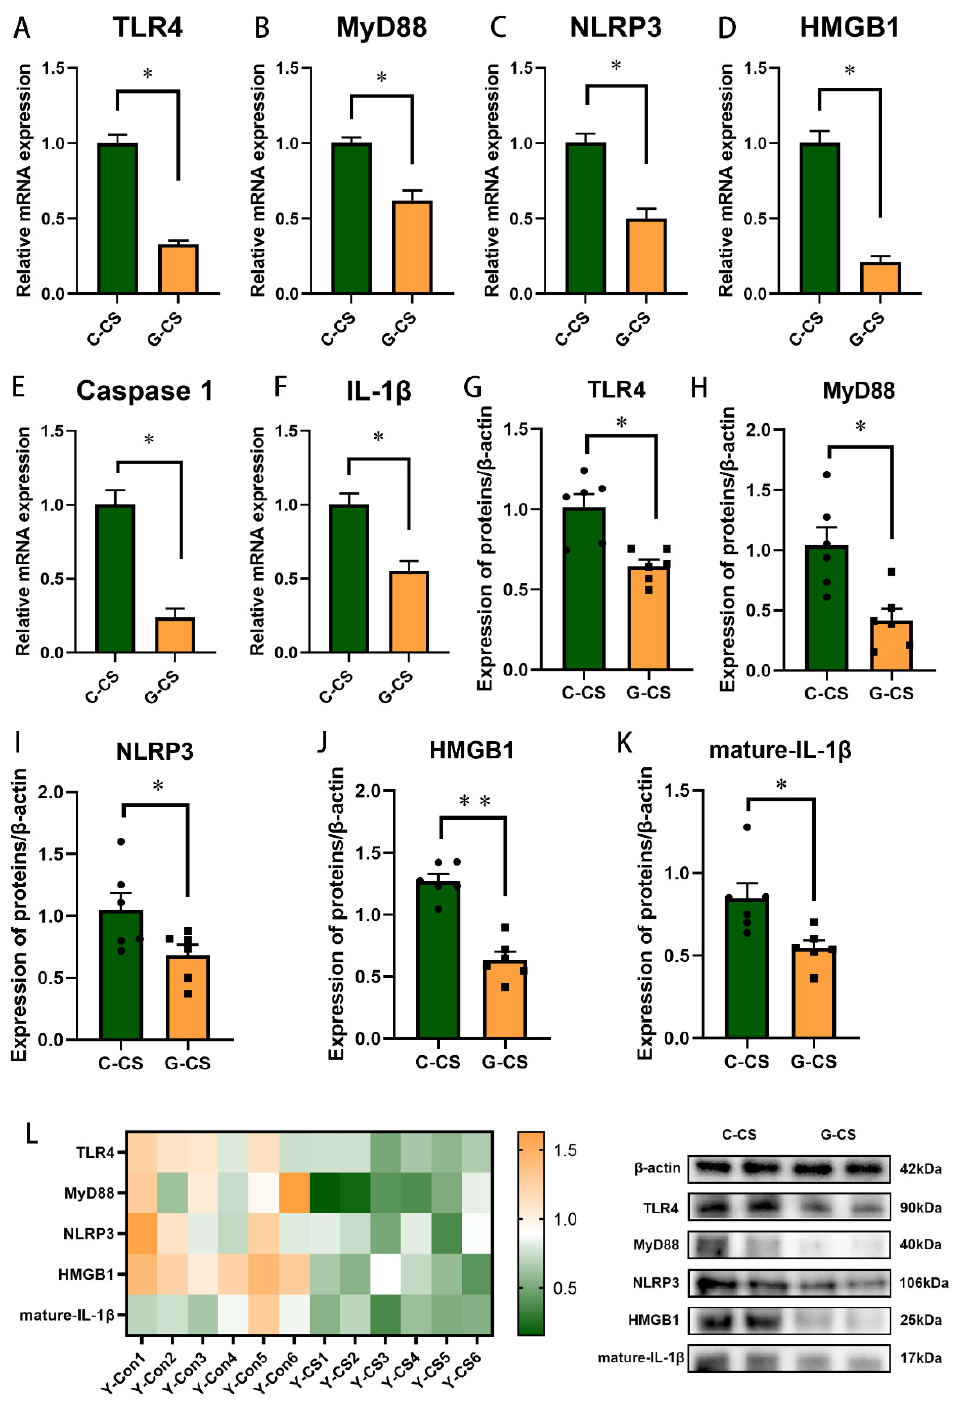
Figure 6. Glucose supplementation improved promotes inflammatory pathways in lung tissue during chronic cold exposure. ( A ) Toll-like receptor 4 (TLR4) mRNA expression. ( B ) Myeloid differentiation main response 88 (MyD88) mRNA expression. ( C ) Nucleotide-binding domain and leucine-rich repeat protein 3 (NLRP3) mRNA expression. ( D ) High mobility group box 1 (HMGB1) mRNA expression. ( E ) Caspase1 mRNA expression. ( F ) IL-1 β mRNA expression. ( G ) TLR4 protein expression. ( H ) MyD88 protein expression. ( I ) NLRP3 protein expression. ( J ) HMGB1 protein expression. ( K ) mature-IL-1 β protein expression. ( L ) Heat map of protein expression levels. Data are expressed as the mean ± SEM, n = 6, * p < 0.05. ** p < 0.01.